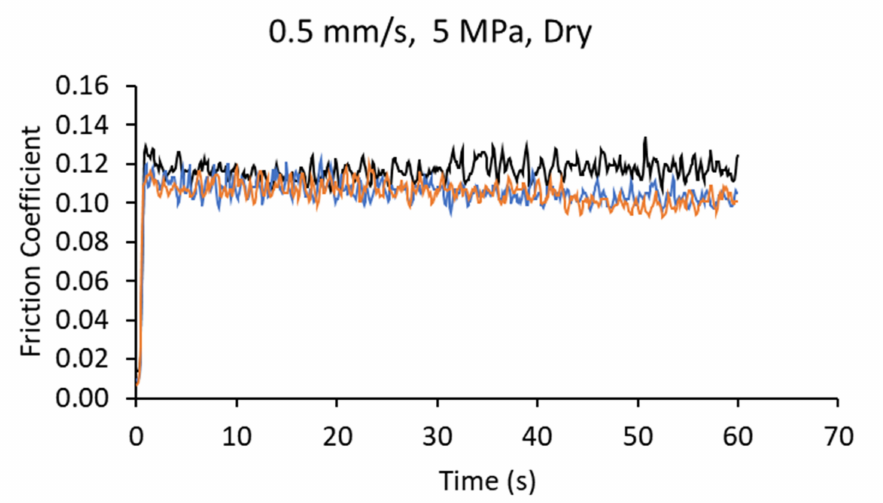
Figure 2. Result obtained for the coefficient of friction at speed of 0.5 mm/s, pressure of 5 MPa, in the dry condition. Each coloured line is a different